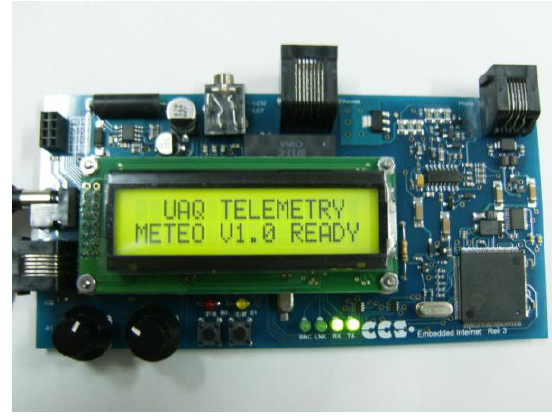
Figure 6. Embedded HTTP Server of base terminal unit.